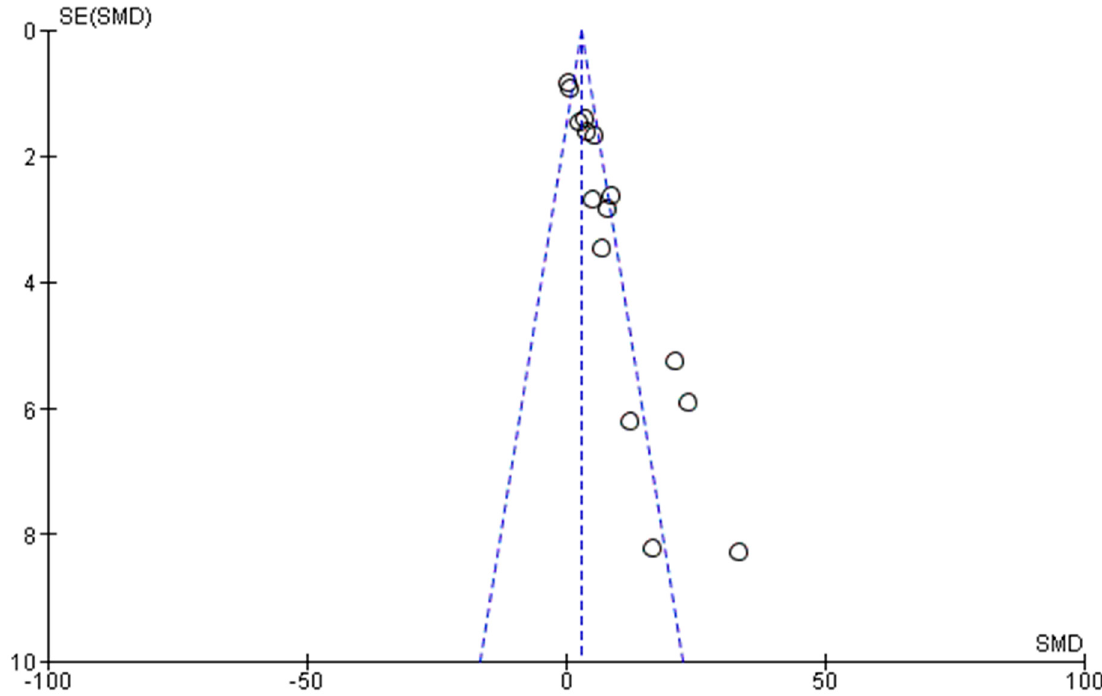
Figure 10. Funnel plot assessing publication bias of investigated studies.